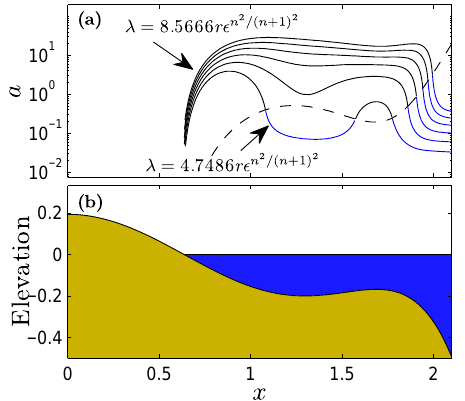
Figure 4. Steady-state profiles, with w ≡ 1, n = 1 /m = 3, r = 0 . 9, γ = 0, ε = 0 . 001, b(x) = ε n 2 /(n + 1 ) ( 9 . 4665 − 28 . 3710 x 2 + 13 . 3975 x 4 − 1 . 97021 x 6 ) . Panel (b) shows the geometry of the bed, which is a scaled version of the sixth-order polynomial bed shape used in Schoof (2007b). Panel (a) shows ground- ing line positions x g against surface accumulation rate a (note the logarithmic scale) for the FL model (dashed line) and the CD calving model (solid line, shown in black where the calv- ing front is grounded, and blue where it is afloat) at values of λ = 4 . 7486 rε n 2 /(n + 1 ) 2 , 5 . 5122 rε n 2 /(n + 1 ) 2 , 6 . 2758 rε n 2 /(n + 1 ) 2 , 7 . 0304 rε n 2 /(n + 1 ) 2 , 7 . 8030 rε n 2 /(n + 1 ) 2 and 8 . 5666 rε n 2 /(n + 1 ) 2 . To identify the curves, note that, for a given grounding line position, larger values of λ invariably correspond to larger values of a